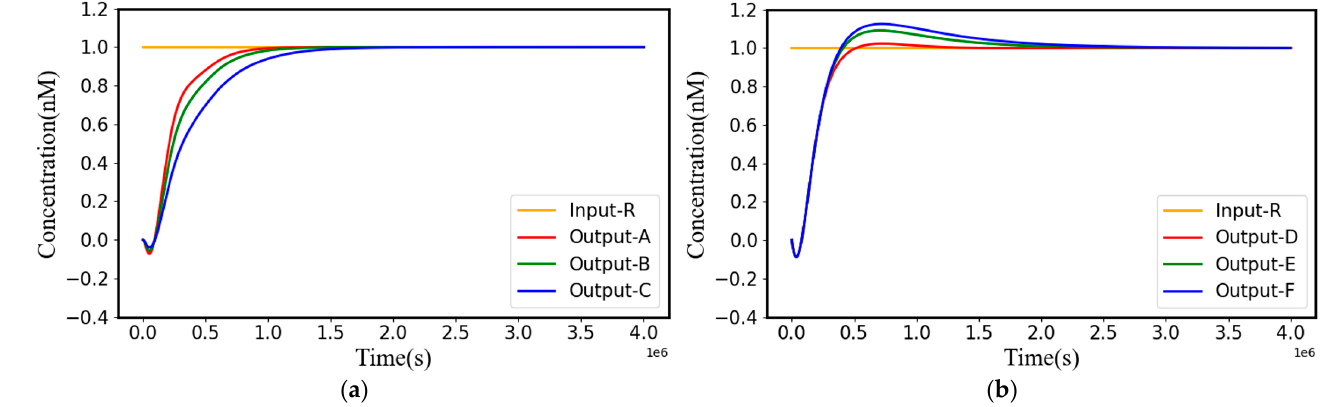
Figure 9. Output response curves of the 2DOF IMC-PID controller: ( a ) variation in controller set-point tracking performance; ( b ) variation in controller disturbance rejection performance.